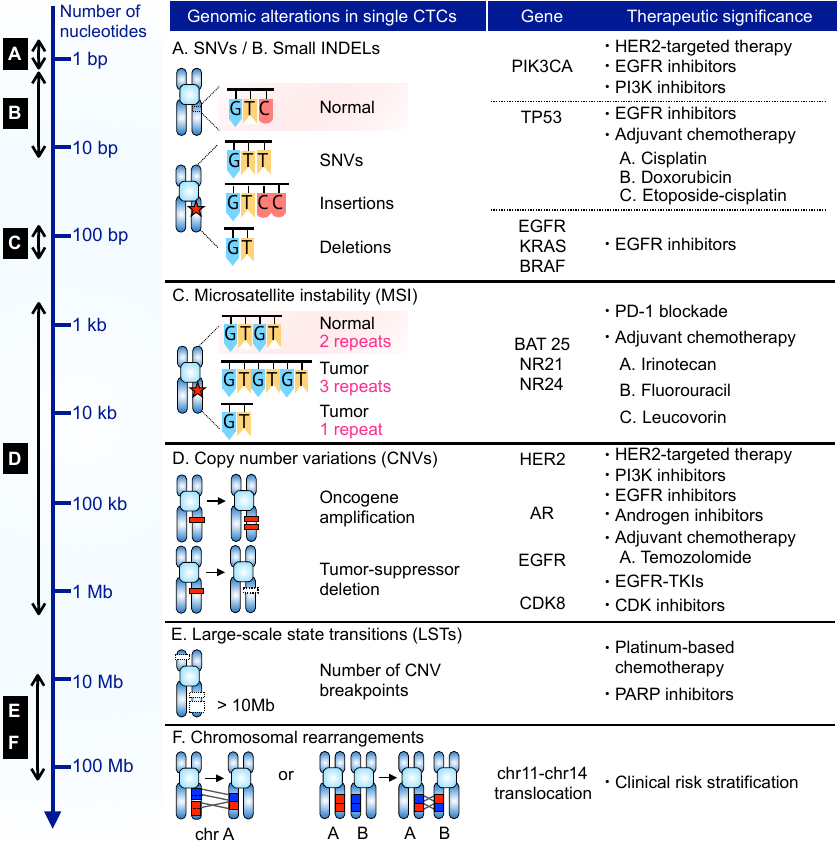
Figure 2. Summary of genomic alterations found in scCTC sequencing